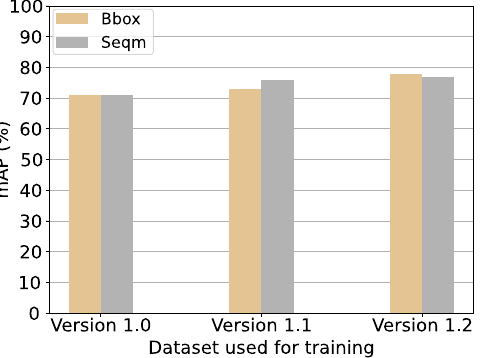
Figure 18. mAP of bounding box and segmentation for each dataset